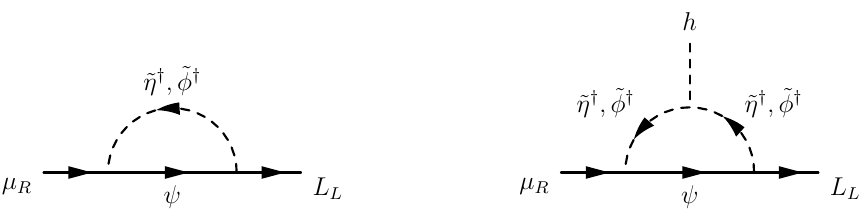
Figure 2 . One-loop diagrams that generate the muon mass and effective Yukawa coupling after electroweak symmetry breaking in the Class 1